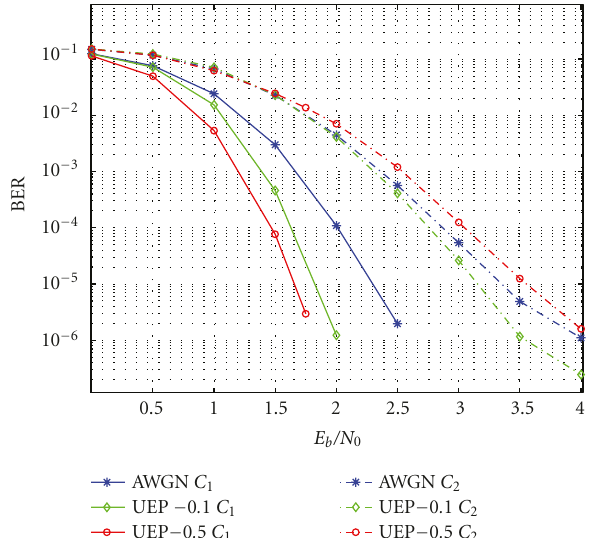
Figure 4: Bit error rate performance of di ff erent classes versus E b /N 0 after 7 decoding iterations. We have improved performance for class 1 and 2 for the the LDPC code optimized with UEP con- straints N =